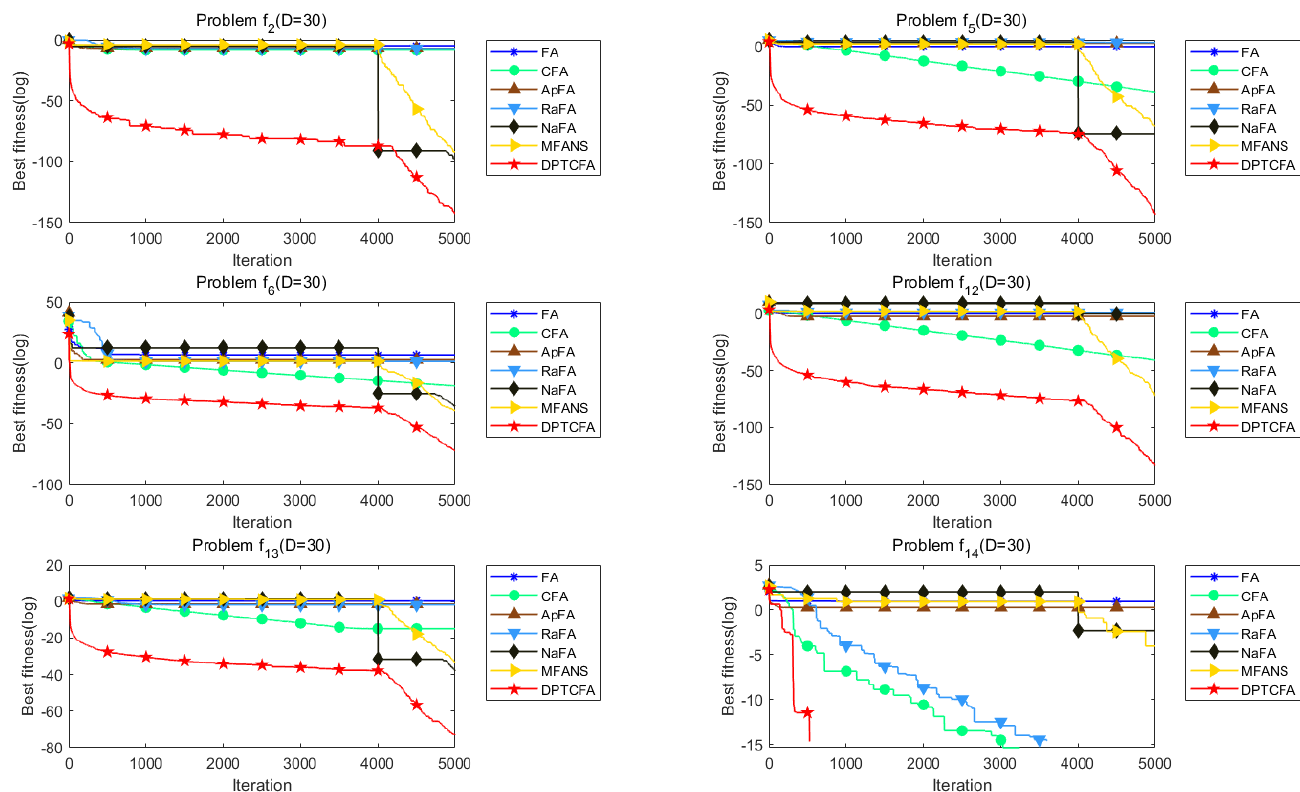
Figure 9. Search curves of DPTCFA and other FA variants ( D = 30). Table 5. Comparison of results obtained by DPTCFA and other FA variants ( D =